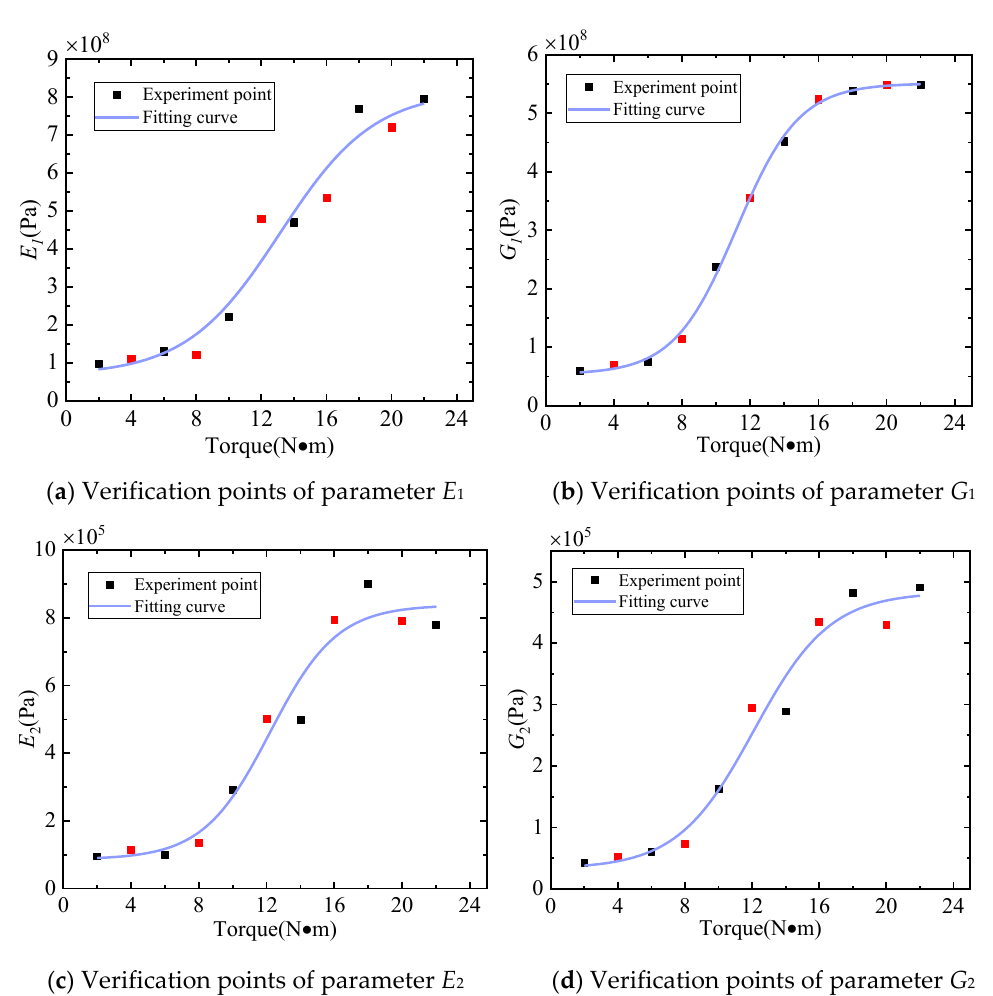
Figure 16. The relation curves of identification parameters change with pre‐tightening torque and verification points.